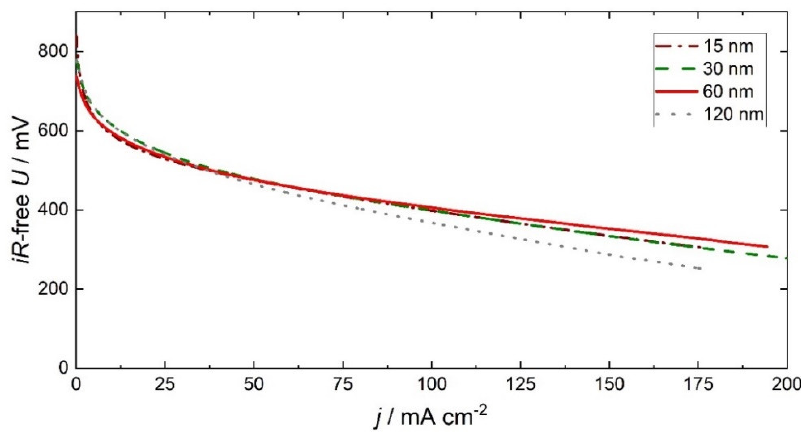
Figure 6. Polarization curves of the MEAs with open-structured GDEs possessing different layer thicknesses from 15 nm up to 120 nm at the cathode and a 60 nm-thick open-structured GDE at the anode under fuel cell operation conditions (513 K, 30 sccm O 2 , 30 sccm H 2 , 0.3 atm H 2